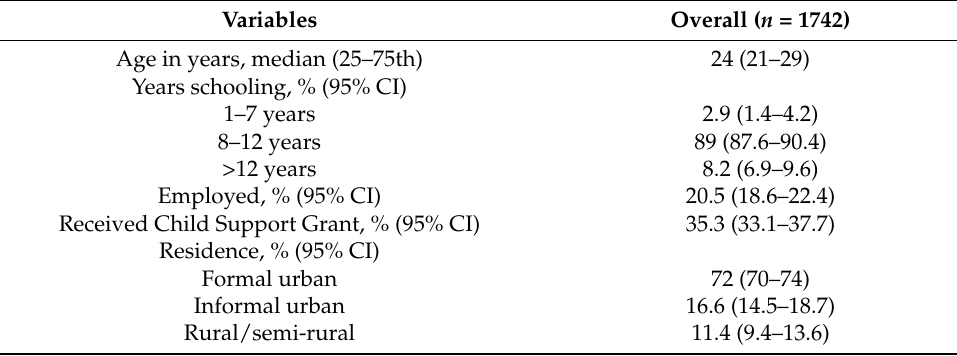
Table A1. Characteristics of women who participated in this